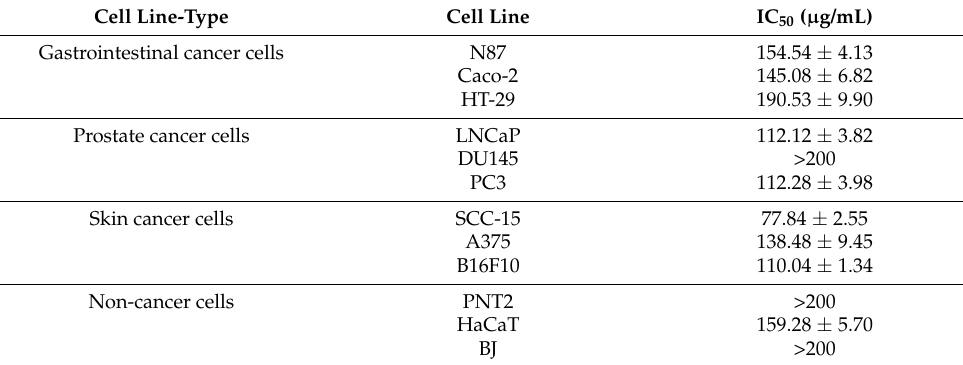
Table 3. Cytotoxic effects of Ferula penninervis methanolic root extract against gastrointestinal cancer (N87, Caco-2, HT-29) cells, prostate cancer cells (LNCaP, DU145, PC3), skin cancer cells (SCC-15, A375, B16F10) and non-cancer cells (PNT2, HaCaT, BJ); data represent the mean ± S.E.M. of three independent experiments performed in